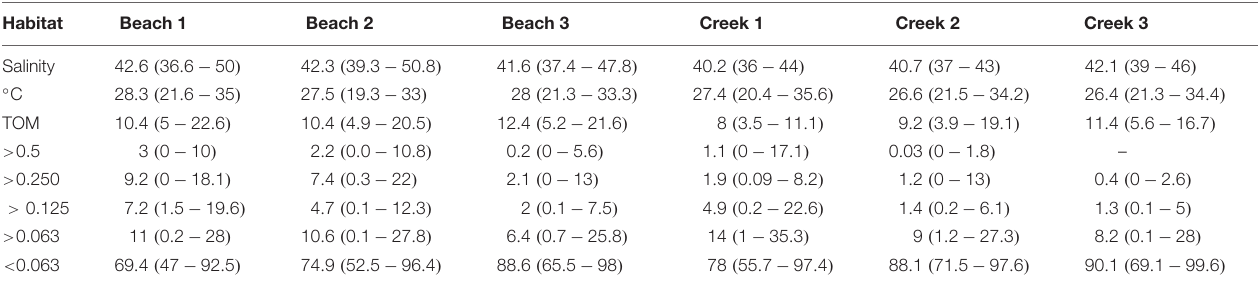
TABLE 2 | Average (minimum–maximum) of environmental variables (salinity and temperature ◦ C) and sediment characteristics, as represented by sediment total organic matter (TOM%) and grain size classes ( > 0.5, > 0.250, > 0.125, > 0.063, and < 0.063 mm).